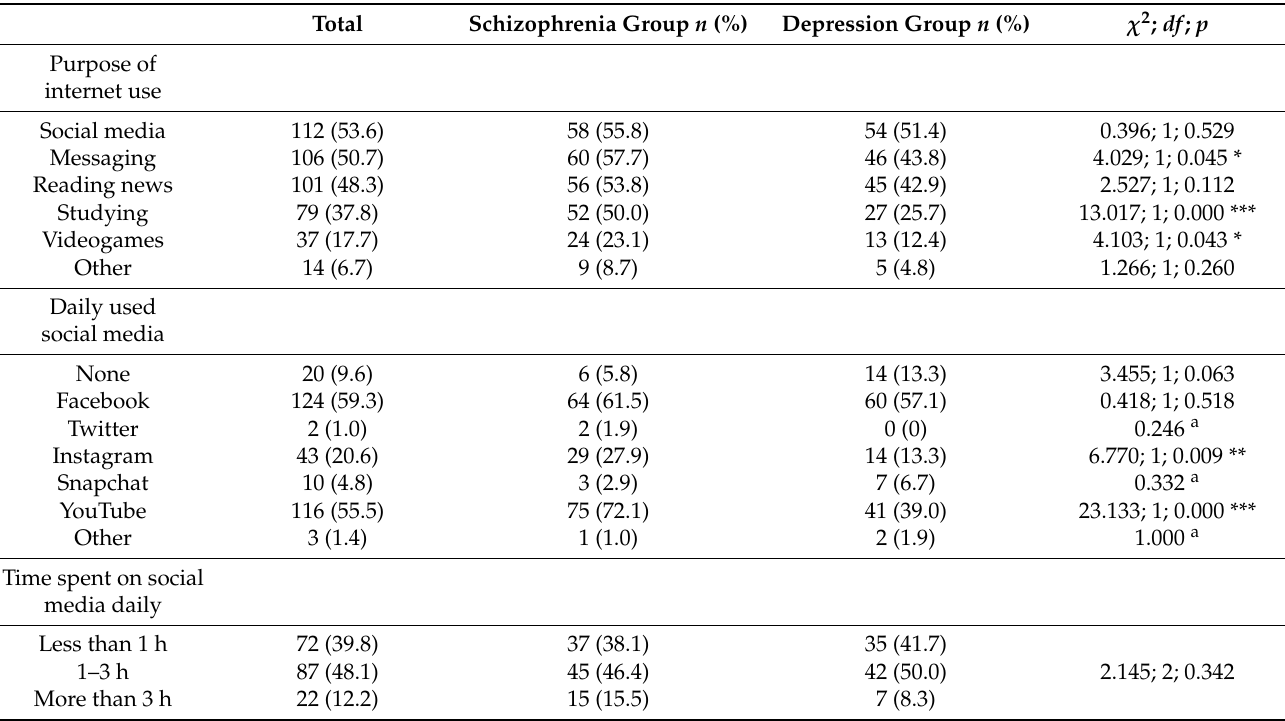
Table 5. General internet use habits.